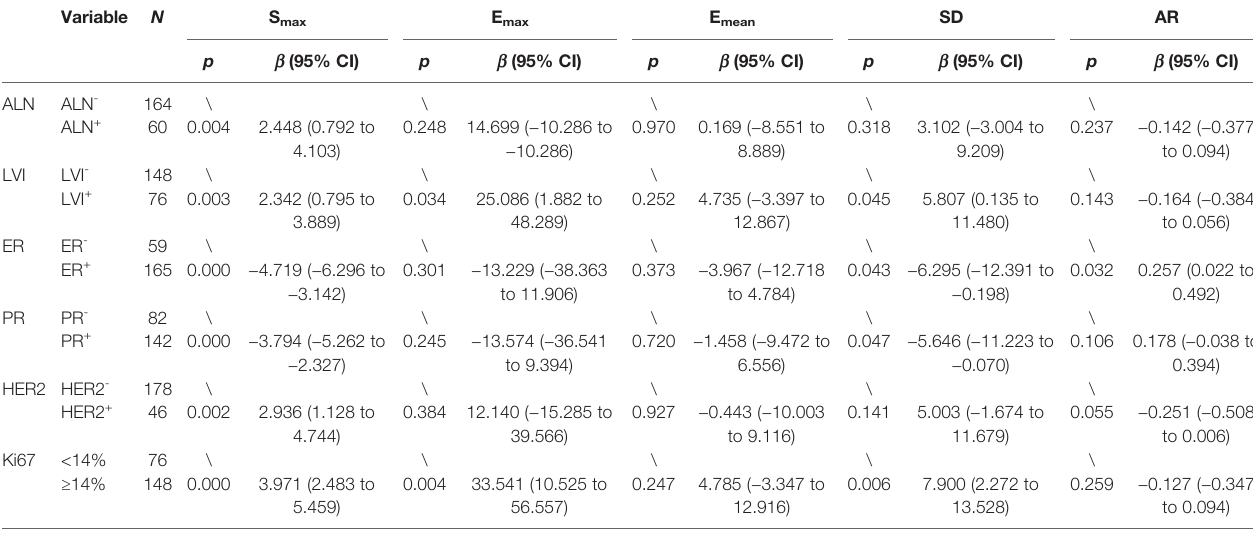
TABLE 3 | Univariate analysis of correlation of ALN, LVI, and immunohistochemical biomarkers with B-mode ultrasound and shear wave elastography parameters. Variable